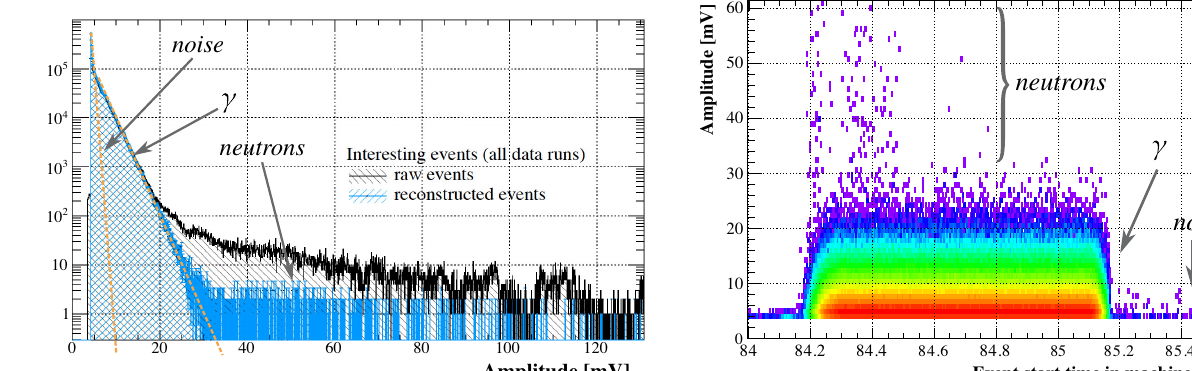
FIG. 6. Distribution of number of IEs over amplitude collected at LINAC4 in 2018. Blue histogram represents reconstructed data, while black refers to the data as recorded.